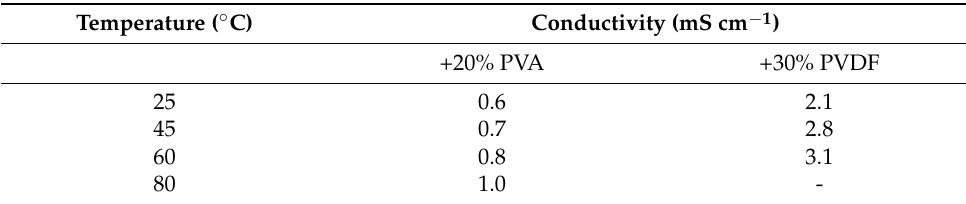
Table 1. Ionic conductivity (Cl − ) of blend membranes with PVA and